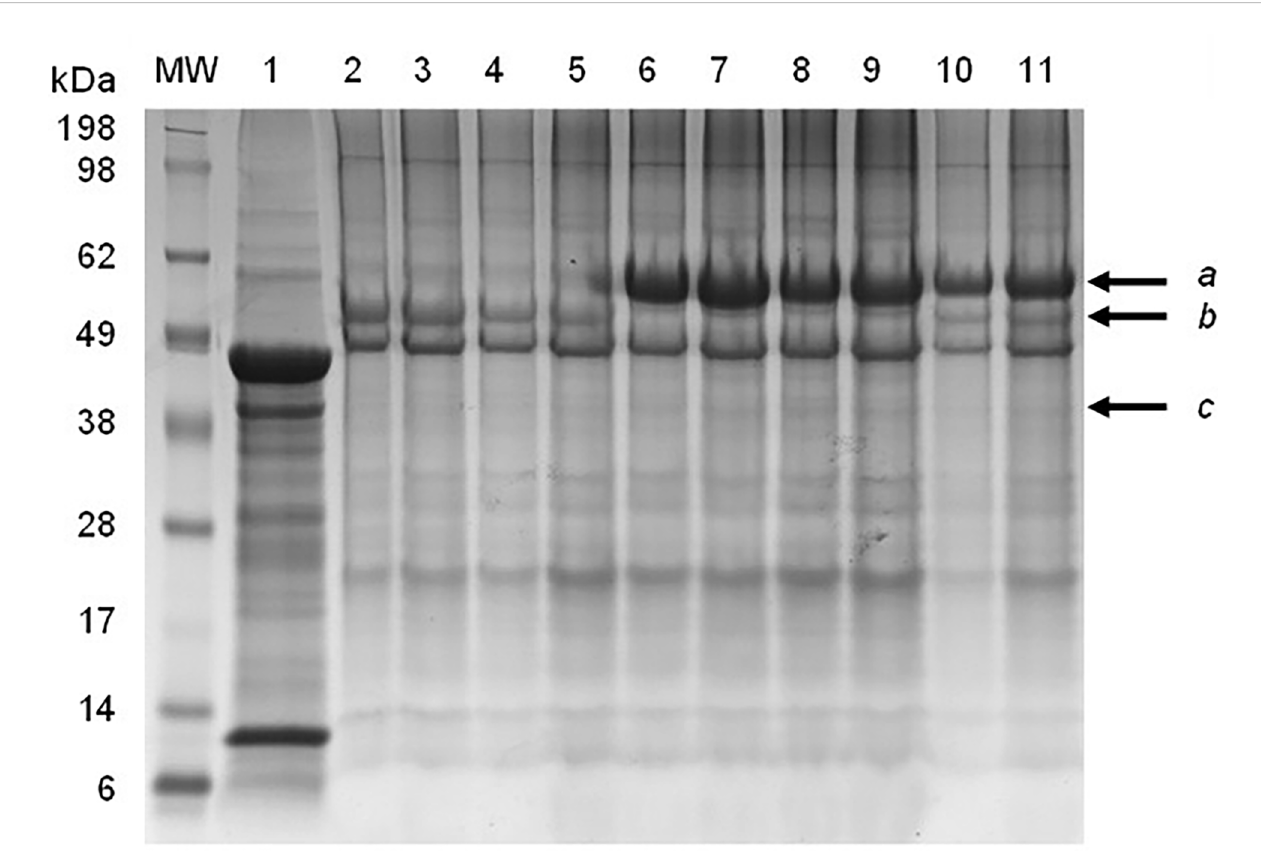
FIGURE 1 SDS-PAGE electrophoresis of partially-puri fi ed plant-produced ND VLPs obtained with different combinations of co-expressed Fusion (F), hemagglutinin- neuraminidase (HN) and/or Matrix (M) proteins. Lane 1: negative control – plant-expressed pEAQ-HT; lanes 2&3: F only; lanes 4&5: F + M; lanes 6&7: HN only; lanes 8&9: HN + M; lanes 10&11: F + HN + M. Arrows indicate the position of the (a) HN (approximately 62 kDa), (b) F (approximately 56 kDa) and (c) M (approximately 40 kD)